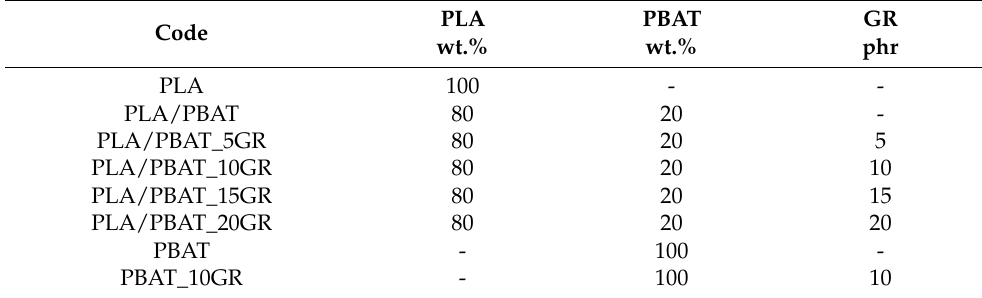
Table 1. Composition and coding of PLA/PBAT/GR studied